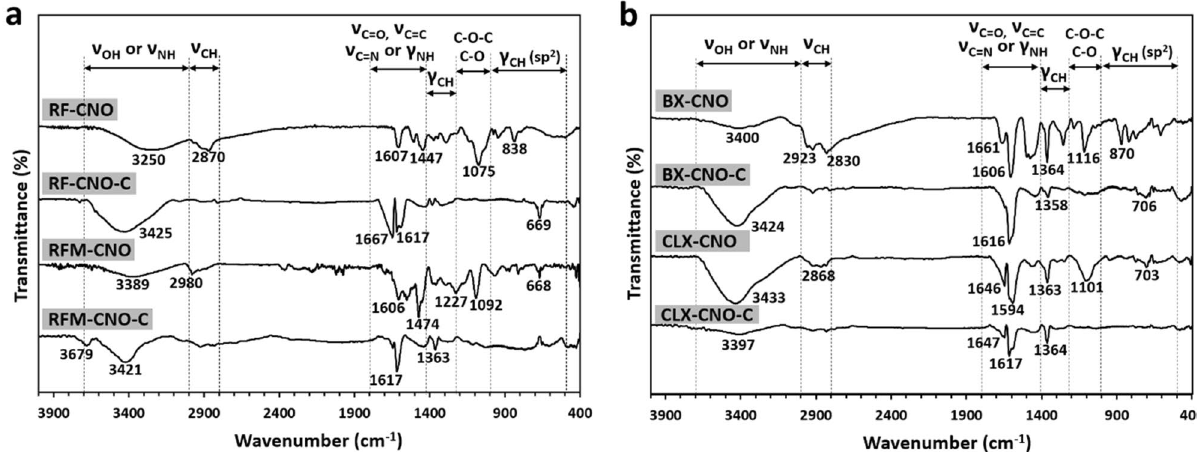
Figure 3. FTIR spectra of ( a ) RF-CNO , RF-CNO-C , RFM-CNO , RFM-CNO-C , and ( b ) BX-CNO , BX-CNO-C , CLX-CNO , CLX-CNO-C .